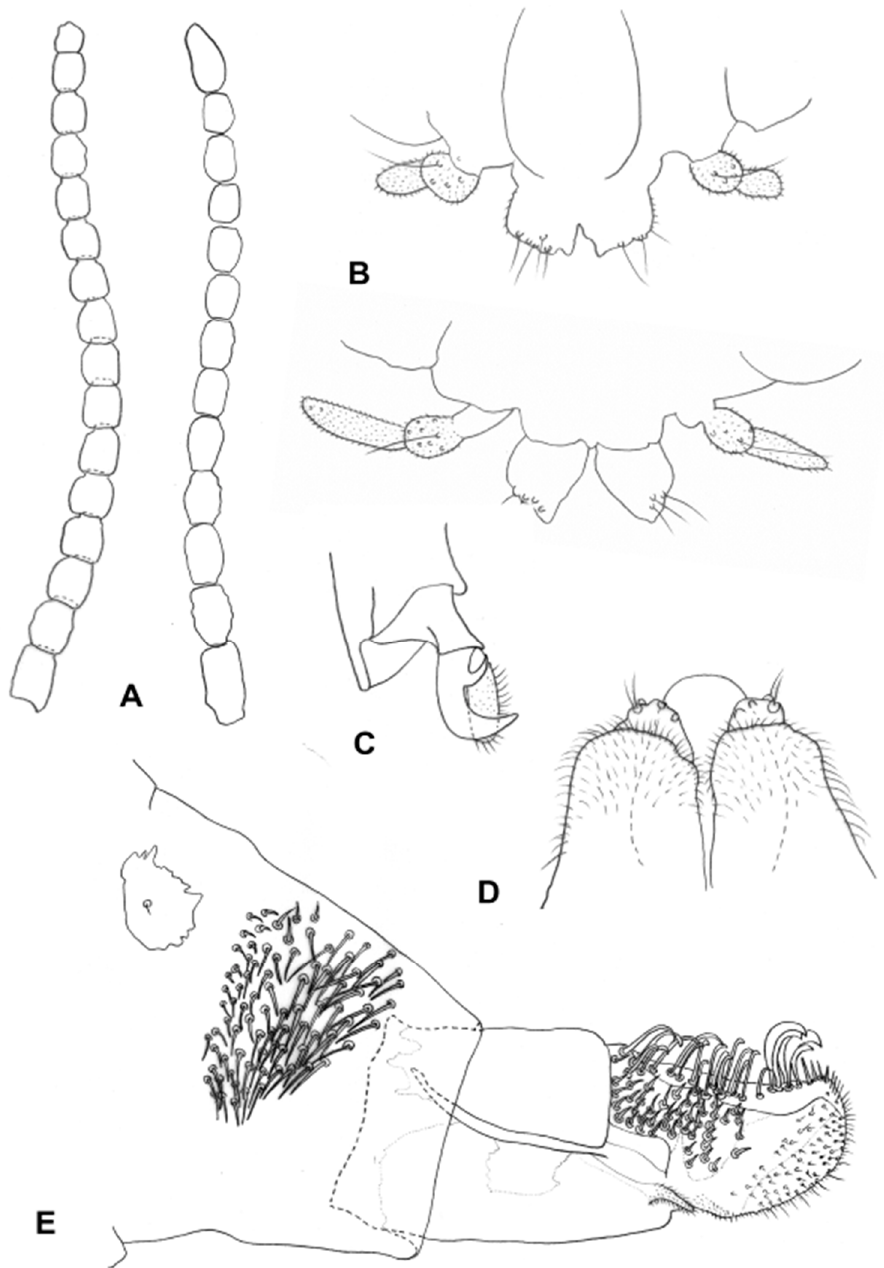
Figure 8. Ruschiola spp. ( A ) Antennal flagellomeres; ( right ): R. succulenta , ( left ): R. attenuata . ( B ) R. attenuata , variation in palpus morphology. ( C ) R. attenuata , acropod, lateral. ( D ) R. attenuata , male aedeagus and mediobasal lobes of gonocoxites, dorsal. ( E ) R. attenuata , ovipositor, lateral. Male abdomen : Mediobasal lobe of gonocoxite slightly shorter than aedeagus, with Thorax : Wing length: 1.46–2.44 mm in female ( n = 36), 1.74–2.47 mm in male ( n = 15). shorter dorsal bulge over longer, rugose apical section (Figure Empodia as long as or slightly longer than bend in claws (Figure 8C).